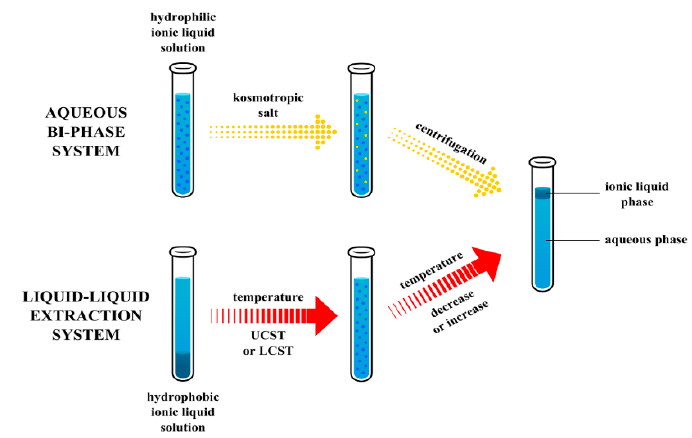
Figure 4. Mechanism of phase separation for hydrophobic and hydrophilic ionic liquids.